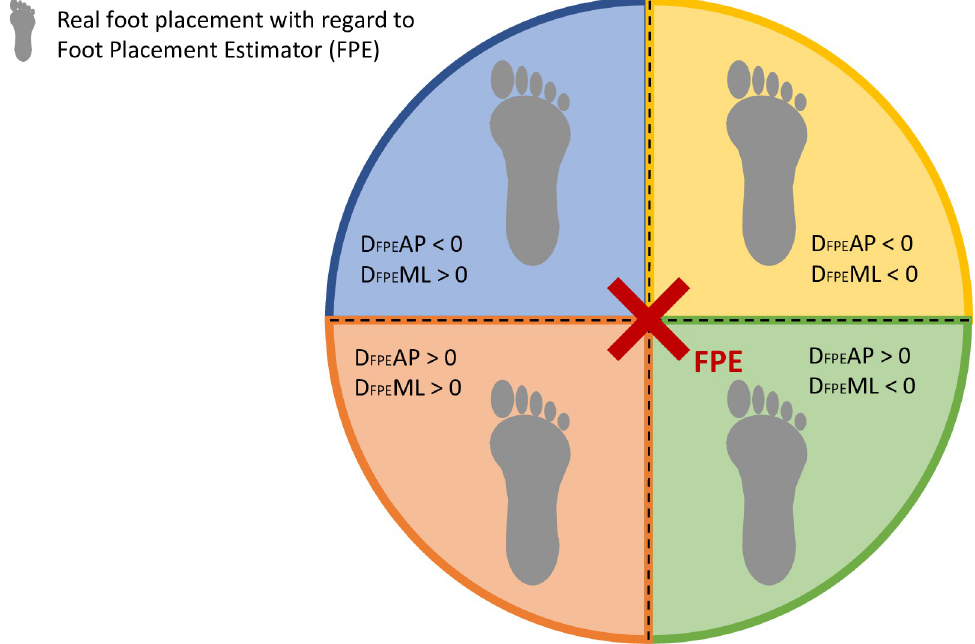
Fig 1. Foot placement estimator values. Values of the distance between the real foot and the foot placement estimator (D FPE ) in the anteroposterior (AP) and mediolateral directions (ML) with regards to 4 areas of real foot placement.